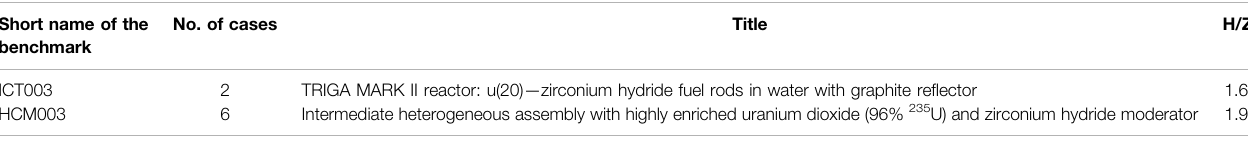
TABLE 3 | k eff of the TRIGA benchmarks.